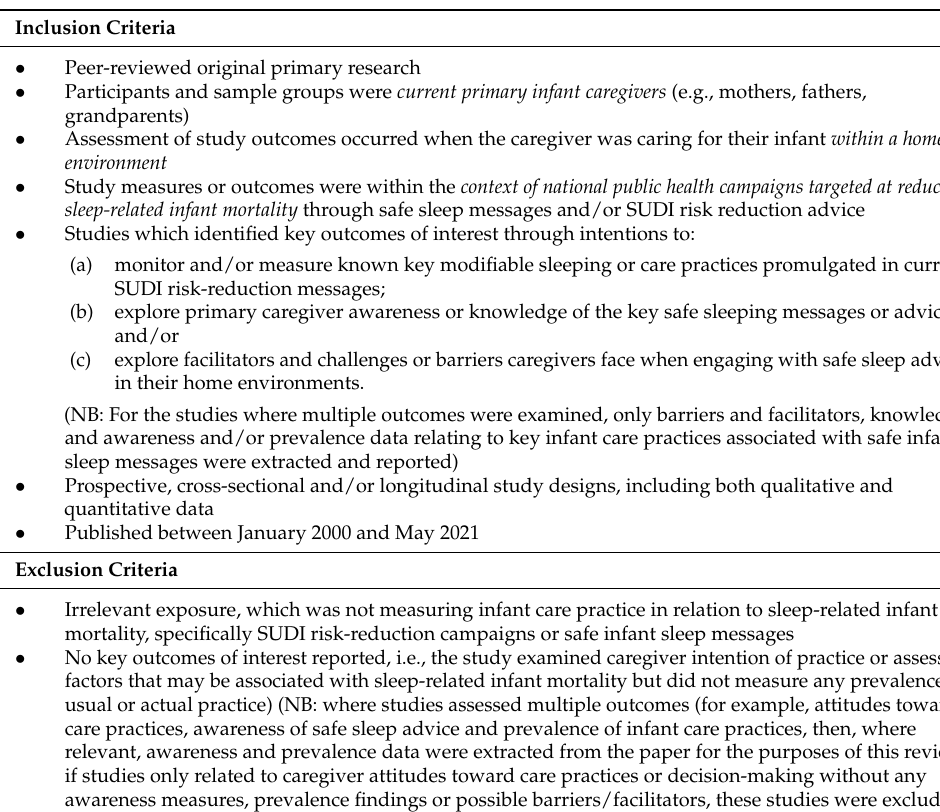
Table 2. Eligibility